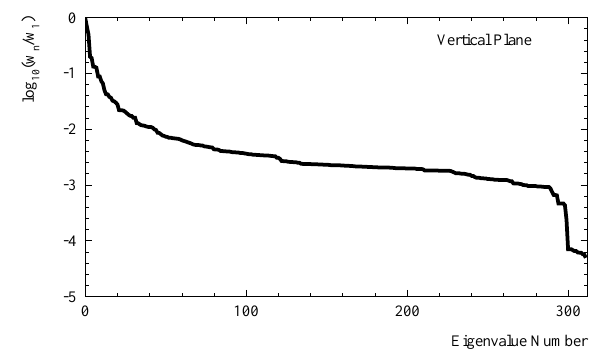
Corrector No. (cid:2) q (cid:1) 9 (cid:2) ) eigen- (cid:2) q (cid:1) 9 (cid:2) (bottom).